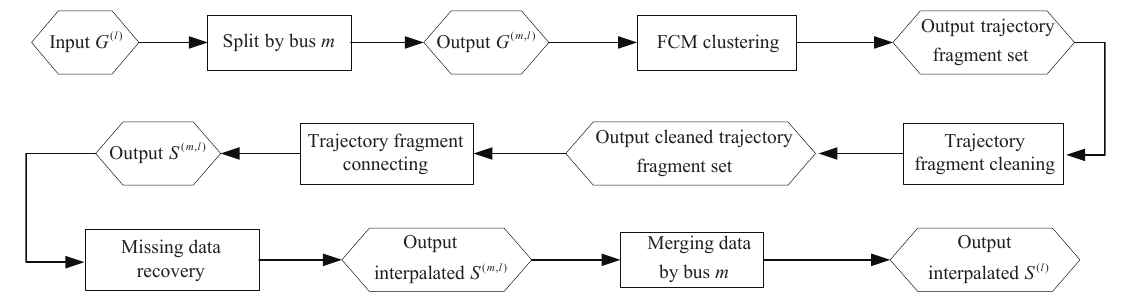
Figure 5. Framework of the data processing for trajectories extraction and missing data